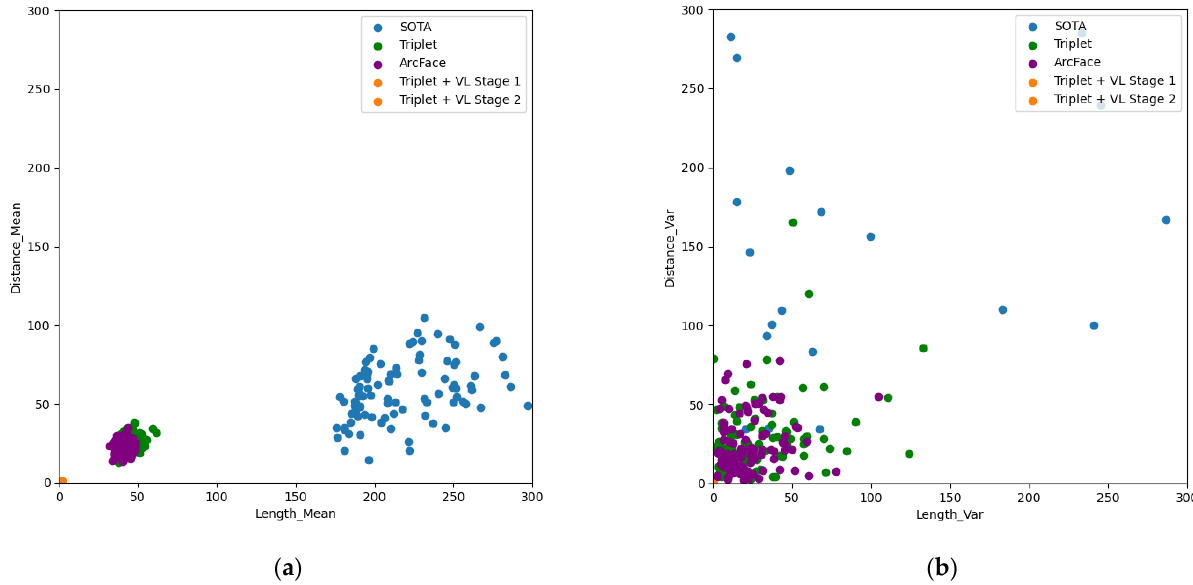
Figure 8. Mean and variance of D , which is the distance between the center of the object’s embedding vectors and the embedding vector, and L , which is the length of the embedding vector, of models trained with the state-of-the-art (SOTA) learning method, the triplet loss learning method, the ArcFace learning method and models trained with the proposed learning method. ( a ) mean; ( b ) variance.